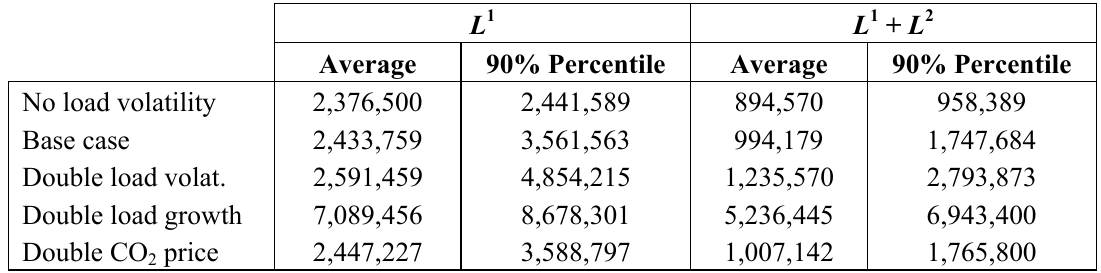
Table 13. Descriptive statistics of the distribution of (cumulative) unserved load across